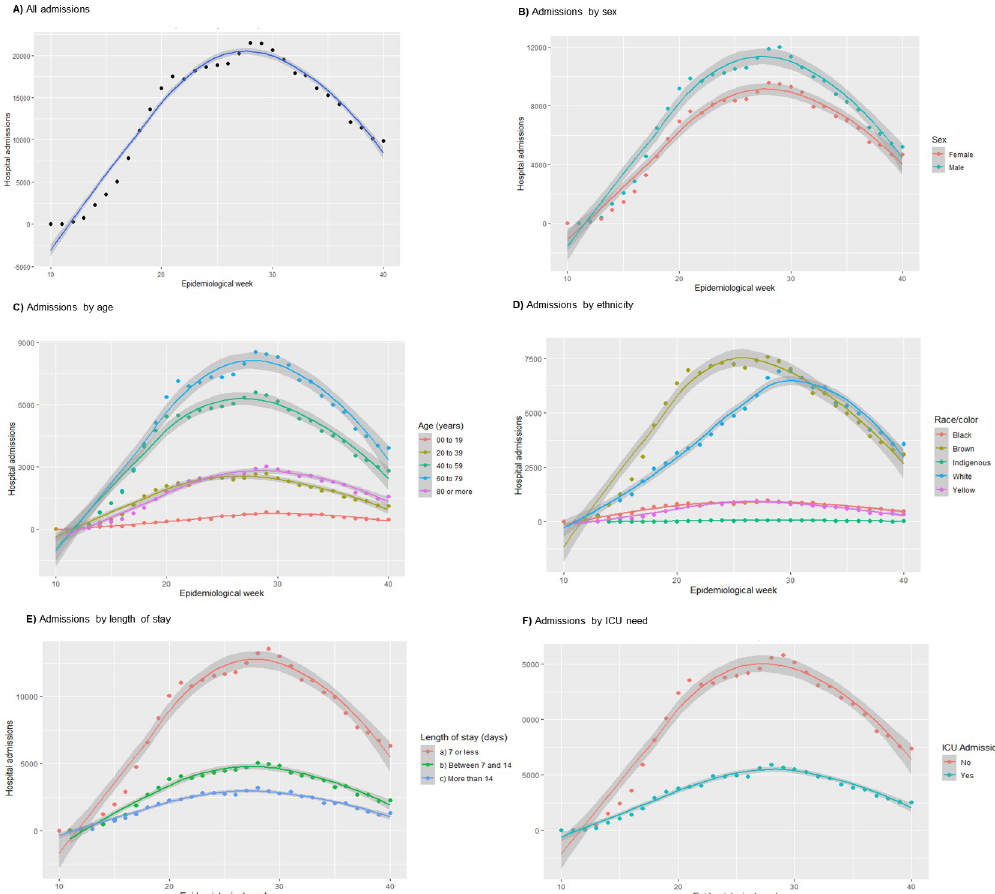
Fig 2. Timeline of 398,063 COVID-19-related hospital admissions stratified by sex, age, comorbidities, ethnicity, length of stay and ICU need during epidemiological weeks 10 to 40, Brazil,